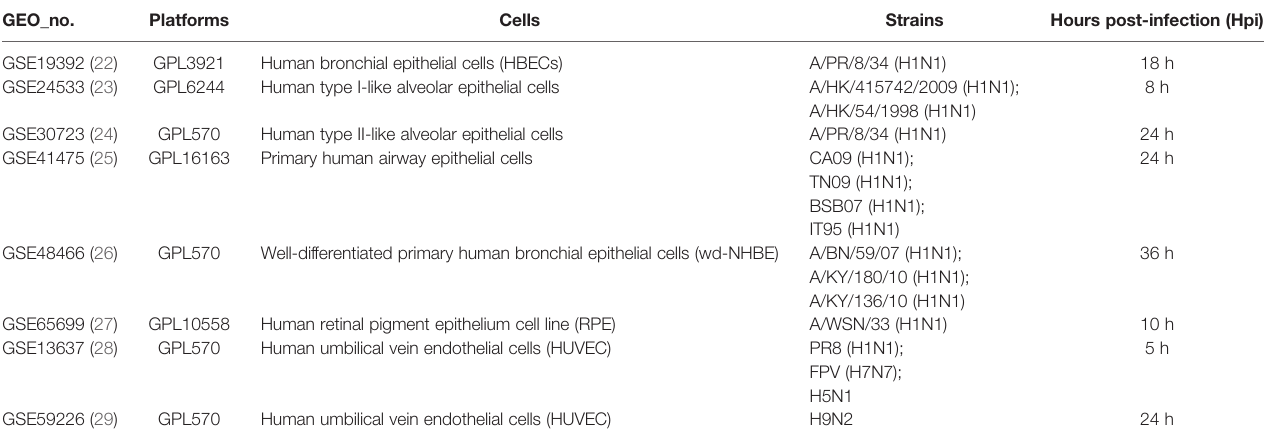
TABLE 3 | The details of gene expression pro fi les on epithelial and endothelial cells from the GEO database.